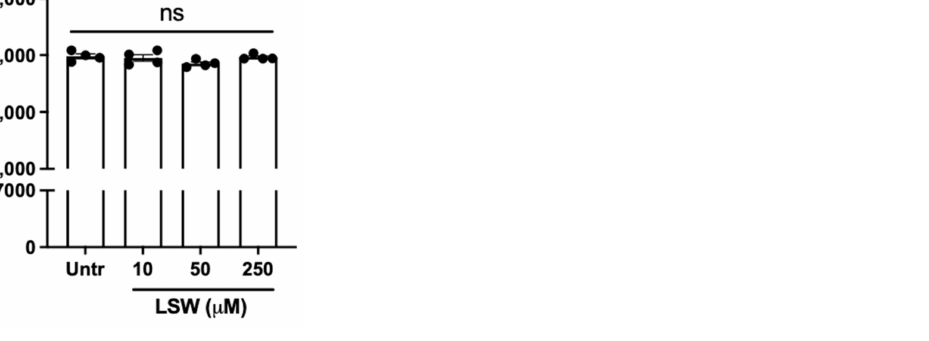
Figure 1. Cell viability upon LSW treatment. EA.hy926 cells were treated with different concentrations of LSW over 24 h before being analyzed by the alamarBlue cell viability assay. Untr., untreated; ns, not significant ( p > 0.05).